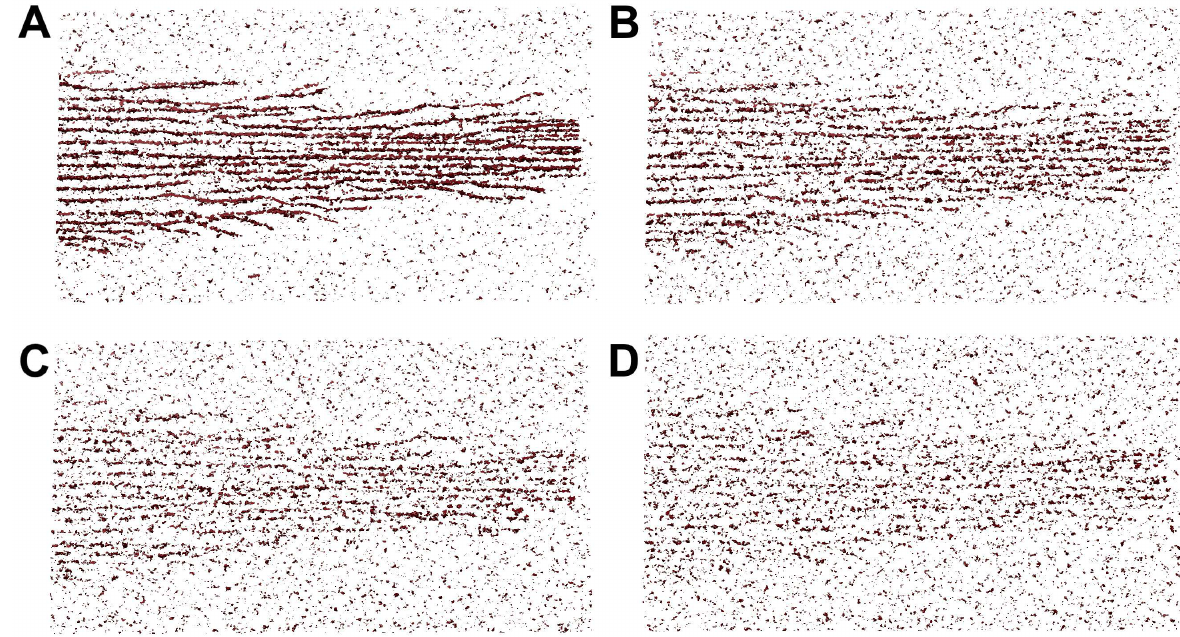
Figure 3. Illustration of the simulated density maps at various noise levels relative to noise in the experimental map [18] (see text). ( A ) noise level 0.40; ( B ) noise level 0.60; ( C ) noise level 0.80; ( D ) noise level 1.00. For the illustration, we used a 10-voxel-thick slab (corresponding to Z -indices 120–129, using experimental map voxel spacing 0.947nm [18]), with an isocontour density threshold of mean plus two times the standard